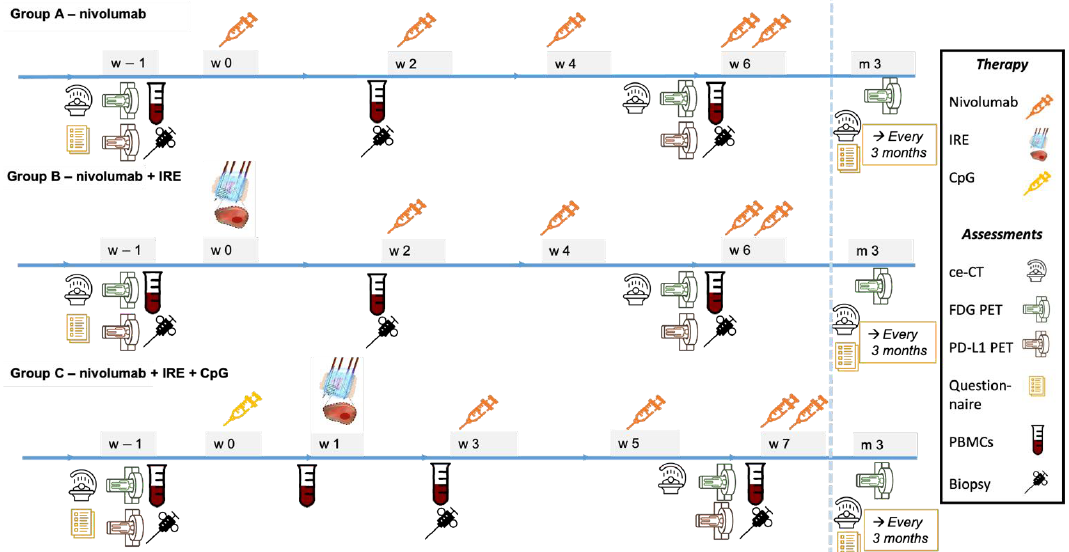
Figure 3. PANFIRE III specified treatment schedule and study assessments per study arm. Arm A: nivolumab monother- apy; intravenous administration of 240 mg nivolumab every 2 weeks for 3 doses followed by intravenous